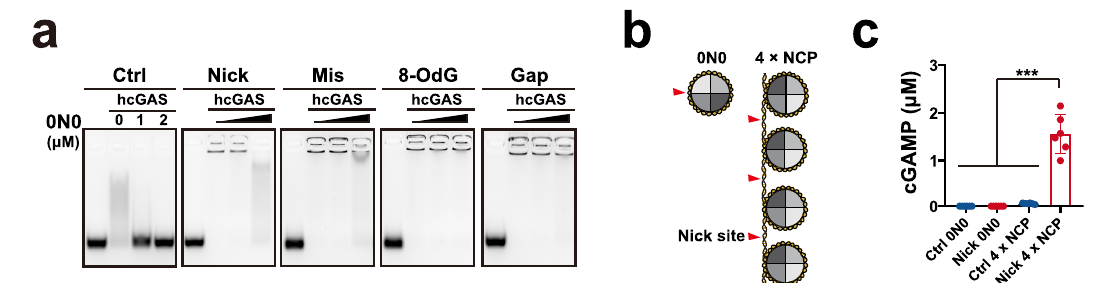
Fig.9|DamageselevatethepotentialofnucleosomalDNAtobindandactivate cGAS. a EMSA assays of 50nM 44bp Cy3-labelled noted ISD binding to 500nM cGAS in the presence of serial dilutions of 0N0 (nucleosome-DNA complex with nucleosomalDNA but without linker DNA). Fifty nanometers of 44bp Cy3-labelled notedISDand500nMhumancGASweremixedwithserialdilutionsofnucleosome (0N0) that was not fl uorescently labelled. After incubation at 37°C for 30min, the mixtures were resolved on agarose gel. b Schematic showing the nick sites in 0N0